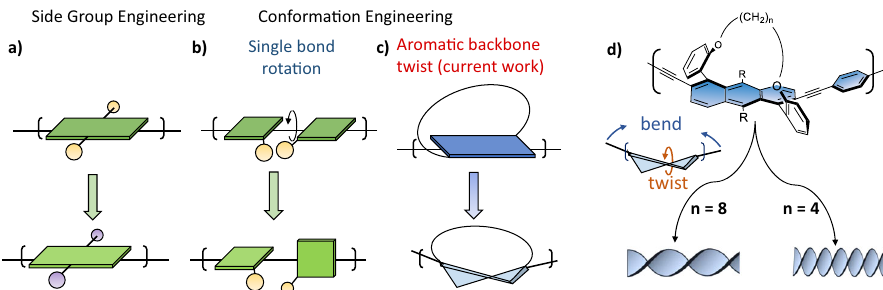
Fig. 1 Approaches for tuning the properties of π -conjugated backbones. a Side-group engineering. Conformational engineering of the backbone by b single bond rotation, and c aromatic backbone twist, as introduced in this work. d Molecular representation of the tethered twistacene π -conjugated oligomers depicted in c . The length of the tether ((CH 2 ) n , where n = 4, 6 or 8 methylene groups; left) determines the primary and secondary structures of the twistacenes by twisting and bending, respectively, and eventually long backbones (polymers) can adopt to a helical conformation with varying degree of helicity. R = CC(CH 3 ) 3